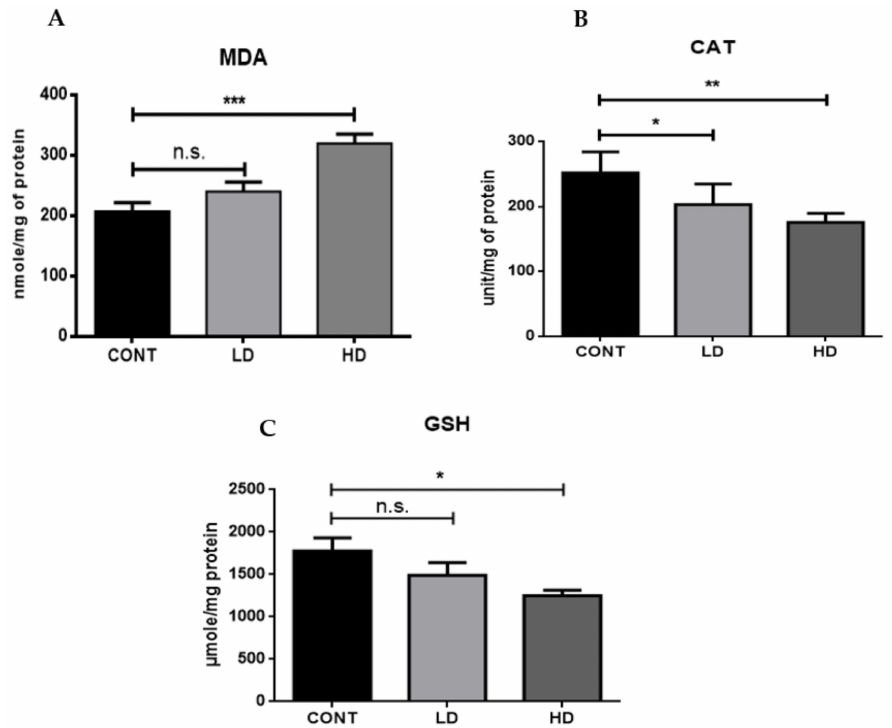
Figure 6. Effects of VTX on oxidative stress status. Biochemical analysis of MDA ( A ), CAT ( B ), and GSH ( C ). Data are presented as mean ± SD ( n = 5). * p < 0.05, ** p < 0.01, *** p < 0.001; n.s., no significant changes were observed ( p > 0.05). Cont, control; LD, low-dose venetoclax (50 mg/kg); HD, high-dose venetoclax (100 mg/kg); MDA, malondialdehyde; CAT, catalase; GSH,